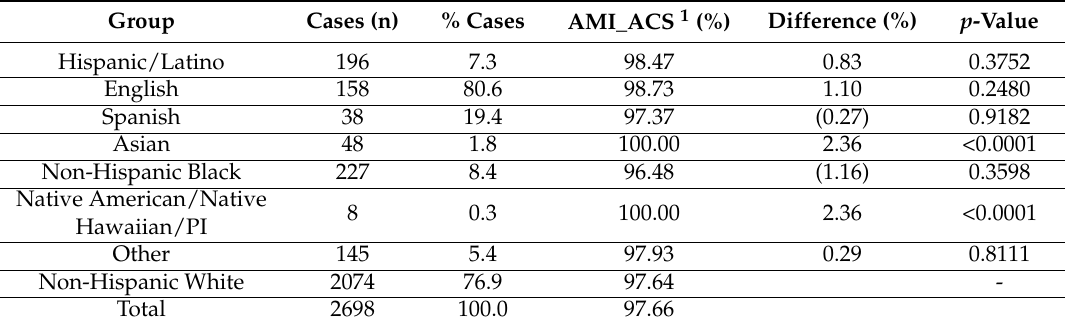
Table 1. Baseline Data Acute Myocardial Infarction